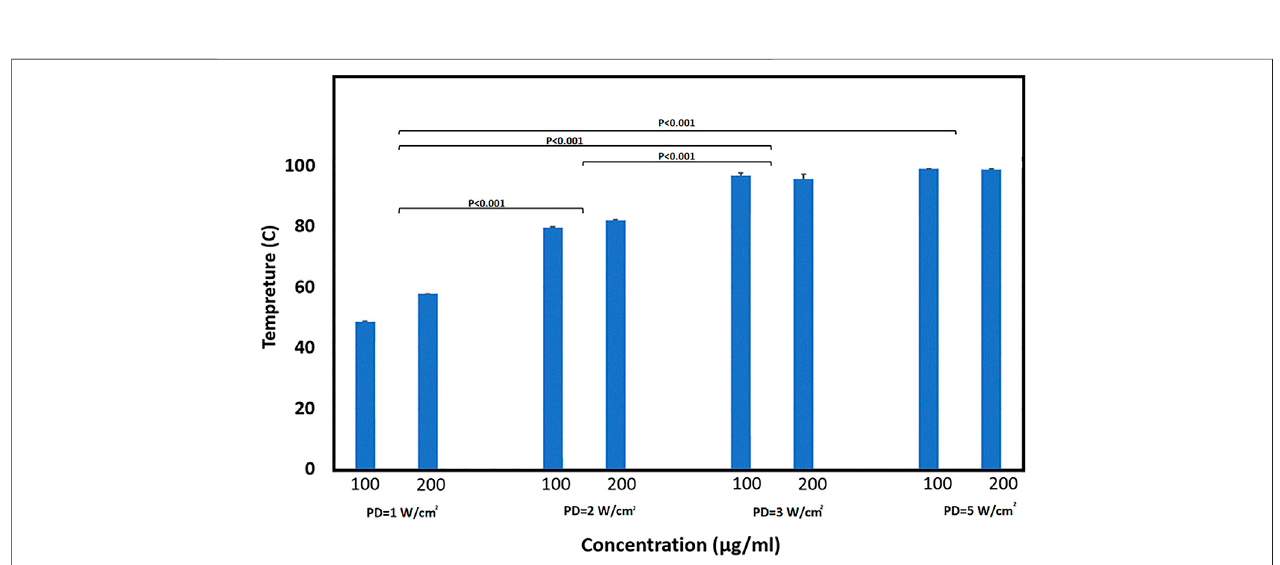
FIGURE3| Averagetemperature obtainedwhenexposingcellmediawithdifferentMXeneconcentrations(100and200 µg/ml)andexposedtodifferentPDs(1,2, 3, and 5 W/cm 2 ). Groups were analyzed by two-way ANOVA followed by a post hoc test. The p -value summery is < 0.001.